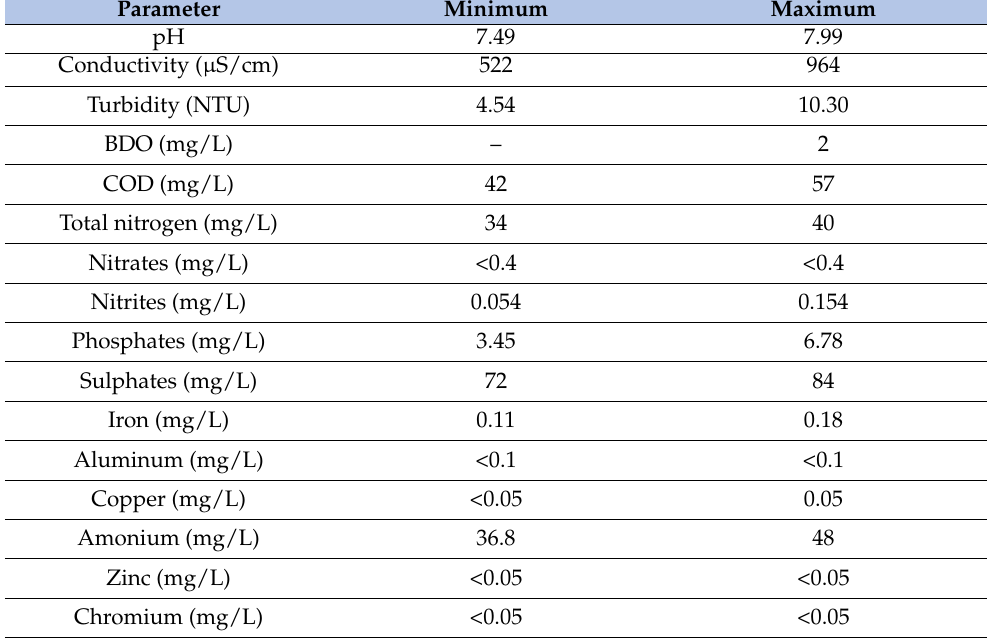
Table 3. Raw water Physicochemical range